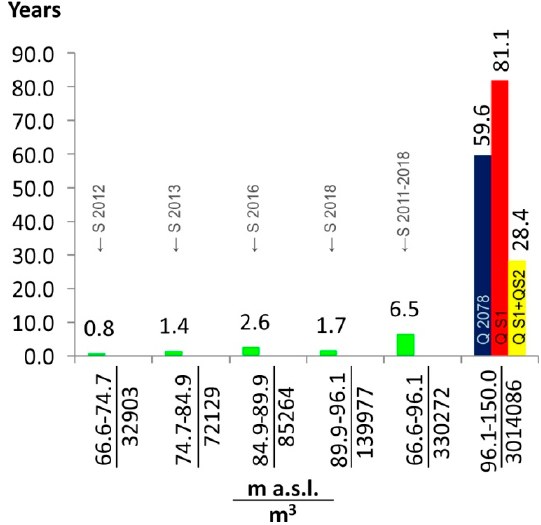
Figure 5. Time of the increase in volume of water retained between specific ordinates’ water levels in the Strzelin I quarry lake (the green columns represent the measured values, while the blue, red and yellow columns represent the prognosed values for supplies Q 2078 , Q S1 and Q S1+S2 ).